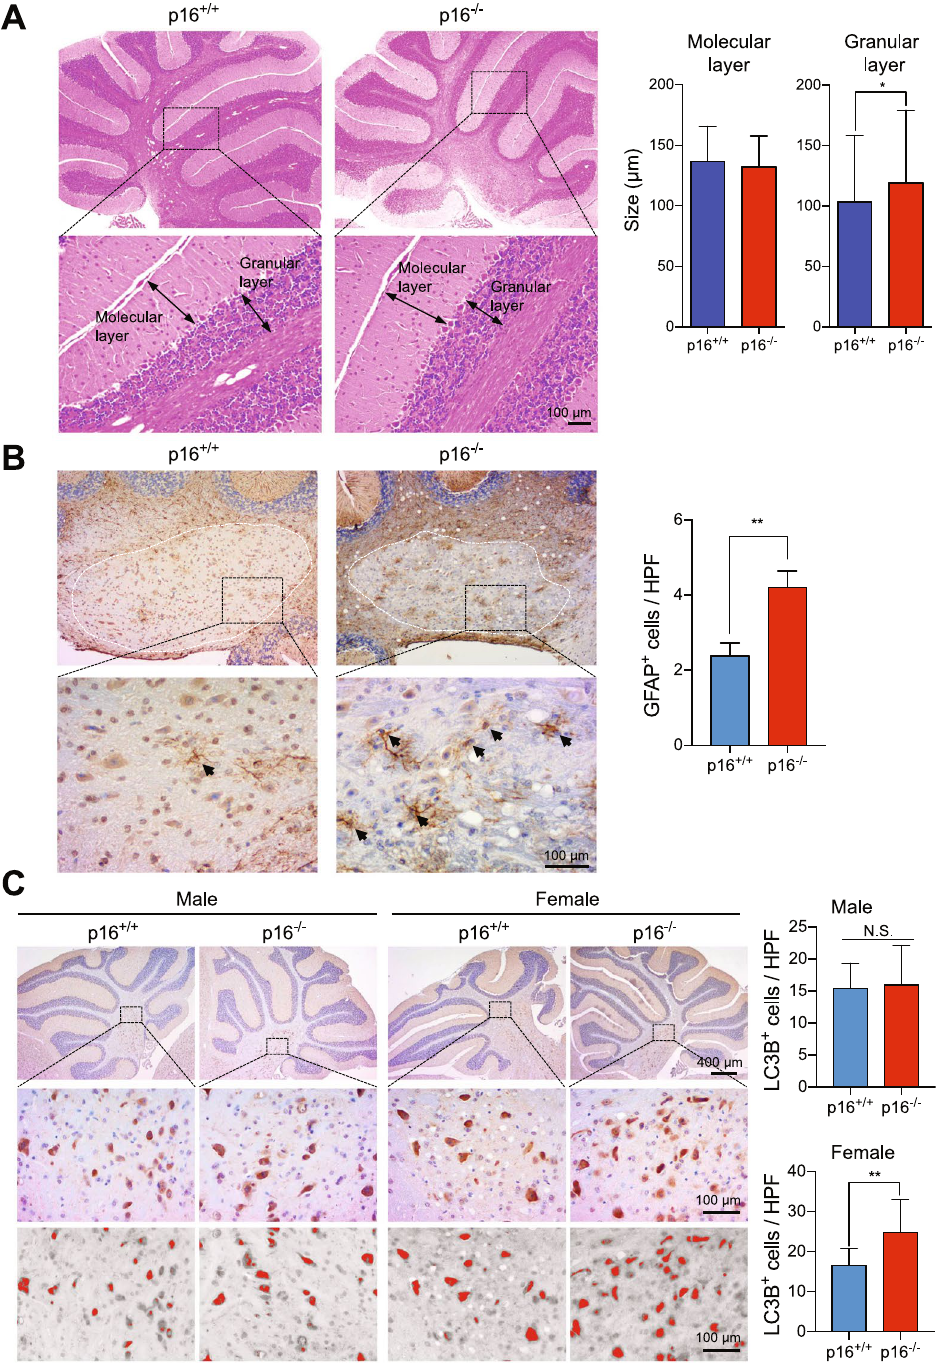
Figure 6. p16 Ink4a regulates senescence in the cerebellum. ( A ) Size of the granular (GL) and molecular layer (ML) in the cerebellum of p16 + / + and p16 − / − female FVB mice (n = 15). ( B ) Sections of deep cerebellar nuclei from p16 + / + and p16 − / − female FVB mice were stained with anti-GFAP, and GFAP + cells (brown, black arrow head) were quantified at high power (right panel) (n = 9). ( C ) Cerebellum sections from p16 + / + and p16 − / − FVB male and female mice were stained with anti-LC3B, and LC3B + cells (brown) were counted in ImageJ as red dots in a gray background (n = 15). HPF, high power field. Results are mean ±